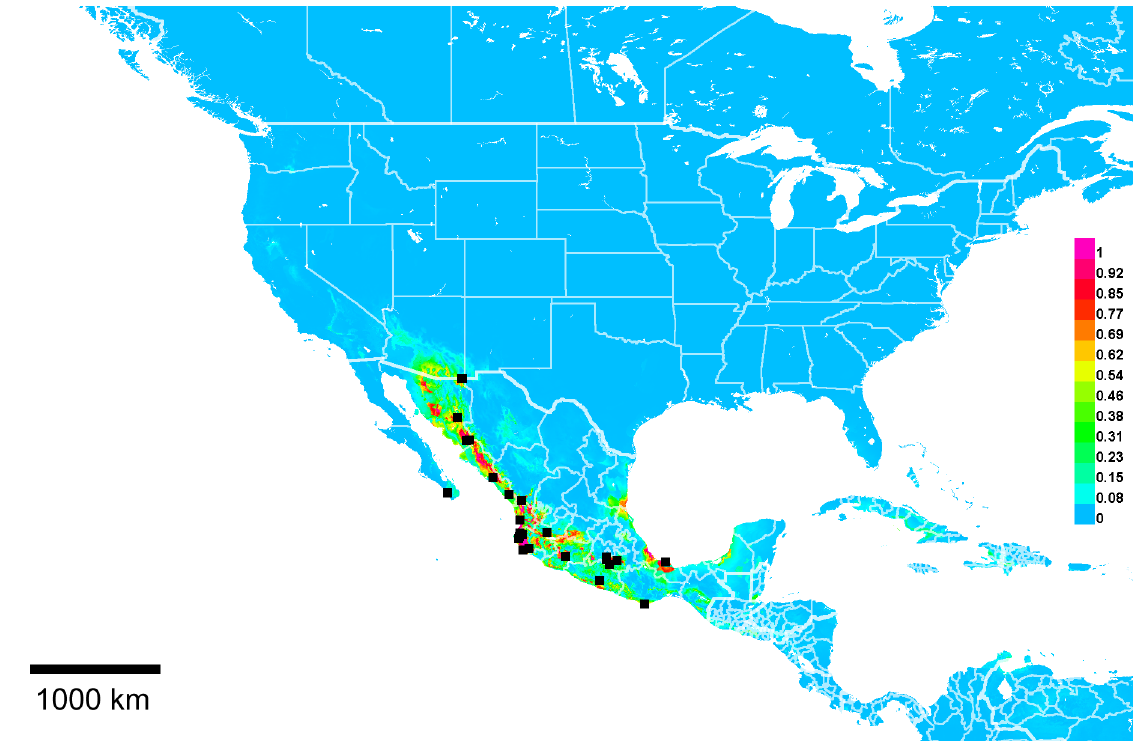
Fig. 44. Georeferenced collection records of Lasioglossum ( D .) magnitegula sp. nov. (black squares) and predicted distribution by maximum entropy ecological niche modelling in Maxent (colour shading). Warmer colours indicate higher cloglog probability of